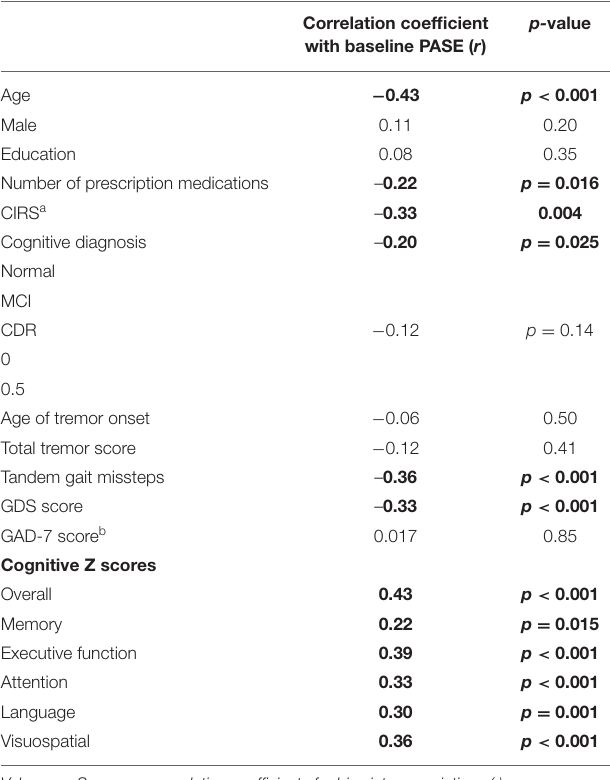
Values are Spearman correlation coefficients for bivariate associations (r). a Average of T2 and T3 values is baseline measure. b T2 is baseline measure. CDR,clinicaldementiarating;CIRS,cumulativeillnessratingscale;GAD-7,generalanxiety disorder seven-item; GDS, geriatric depression scale; MCI, mild cognitive impairment; PASE, physical activity scale for the elderly. Bolded values represent significant correlations.